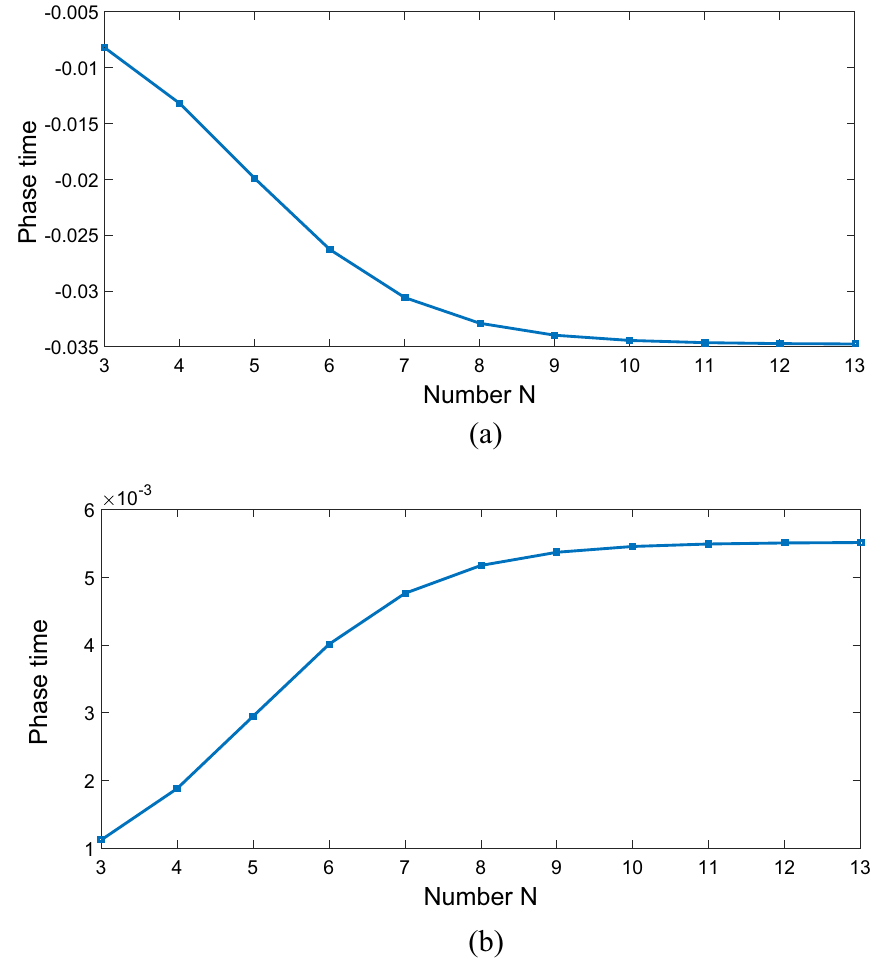
Figure 5. The Hartman effect in a 1DPC’s with structure ( AB ) 2 ADA ( BA ) N when only one control field (cid:31) c has an optical vortex with OAM numbers l = 2 ( a ), l = − 2 ( b ). Here �ϕ = 0, � p = 0.2 γ , � d = 0.9 γ , ω c = 1 µ m, 4, E � = π c = γ , and r = (cid:31) Rabi-frequencies and relative phases of the applied fields but also by using a vortex beam as a controlling field. In the lateral case, two new parameters i.e. the orbital angular momentum ( l ) and the azimuthal phase (�) can be utilized as controlling parameters of the Hartman effect. We again emphases that switching the Hartman effect from negative to positive and vice versa is a very effective method in creating and controllable subluminal and superluminal light propagation.